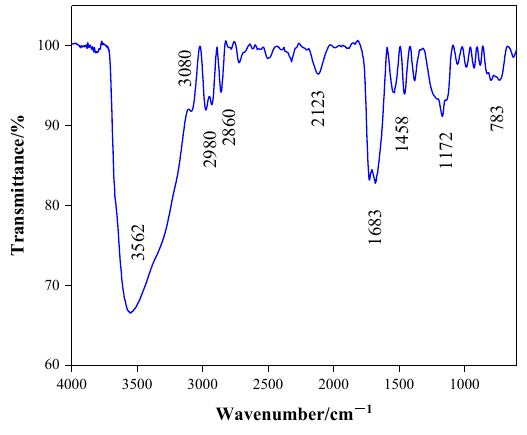
Figure 1. FT − IR of PNBAM.